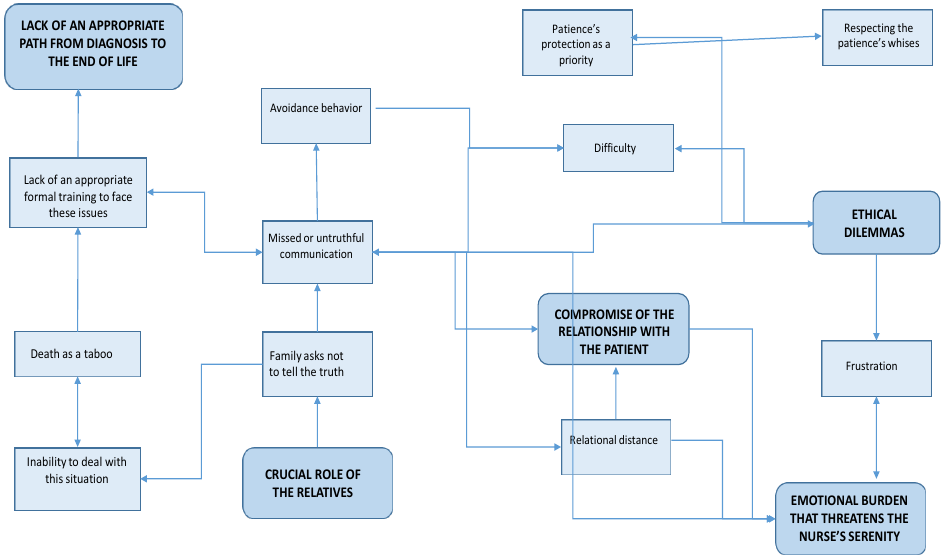
Figure 1. Main critical issues described by the participants.